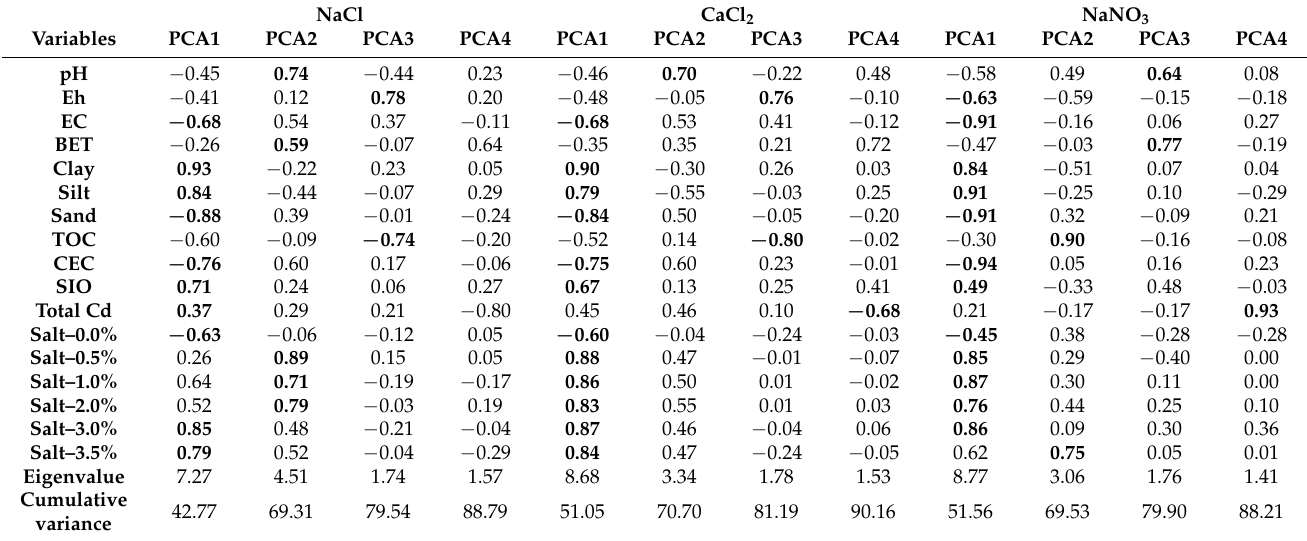
Table 3. Principal component analysis (PCA) results for the Cd release data for different salts and salt